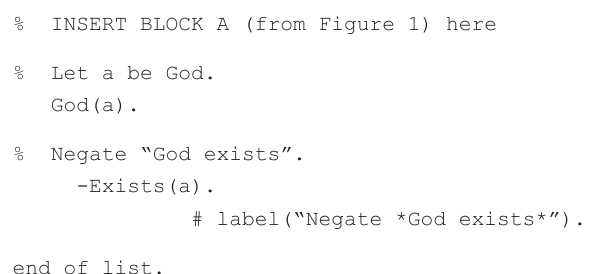
Figure 3: A mace4 script for generating a model that shows the independence of (GE) from the DAPI. Executing the mace4 script shown in Figure 2 produces the model shown in Appendix 1. Thus, (GE), and therefore by the Deduction Theorem, Prop. 11 (“God … necessarily exists”), cannot be derived from